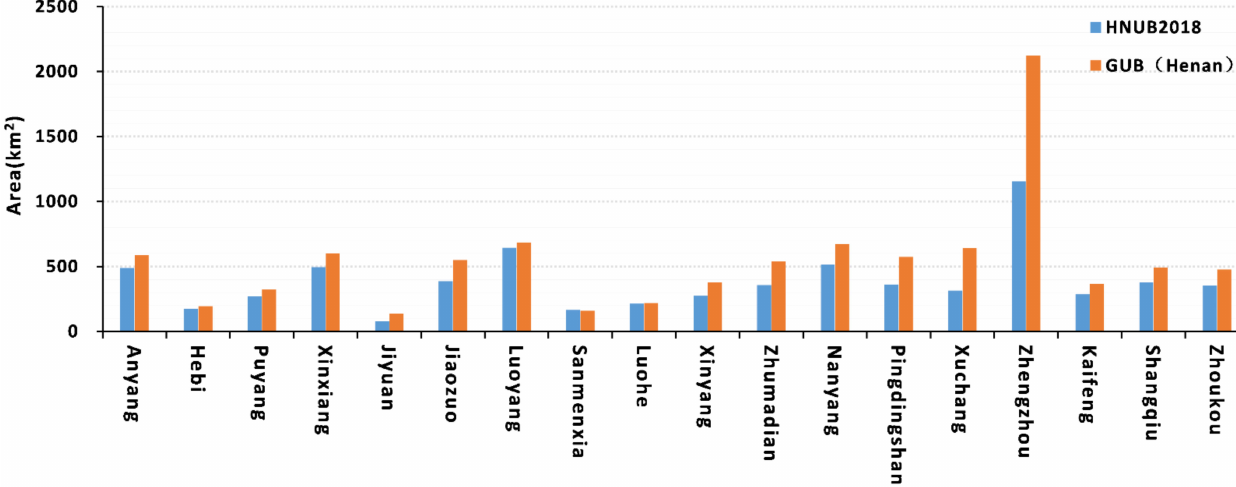
Figure 6. Area comparison between HNUB2018 and GUB (Henan) in